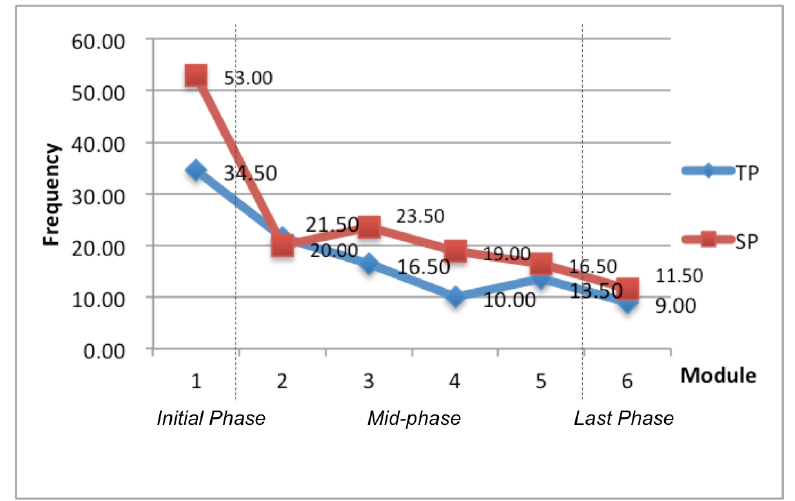
Figure 2. Tutor's social and teaching presence in each